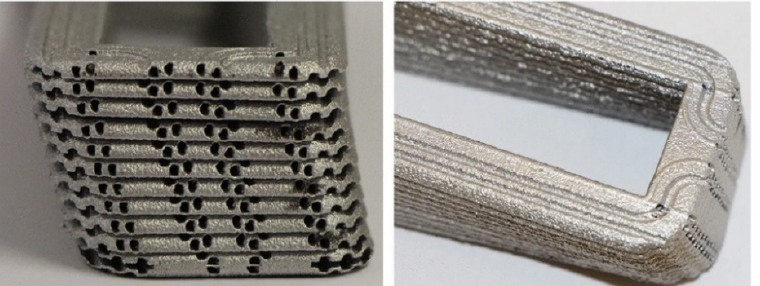
Figure 17. Additively manufactured aluminum alloy windings with a hollow structure for direct conductor water cooling [94]. conductor water cooling. Reprinted with permission from Ref. [94]. Copyright 2018